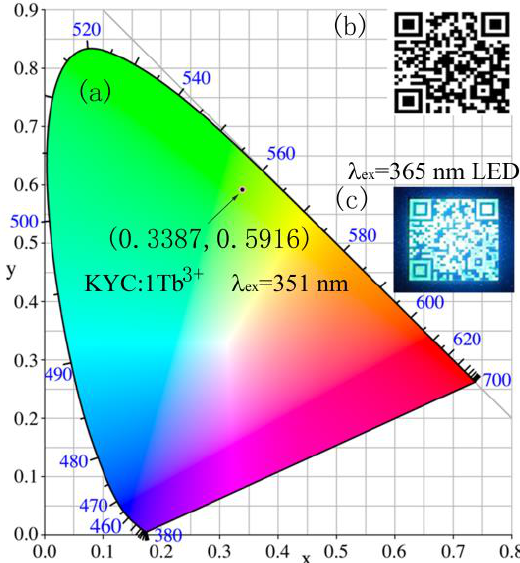
Figure 6. ( a ) Chromaticity point of phosphor; ( b ) Quick response code; ( c ) Quick response code excited by 365 nm LED.